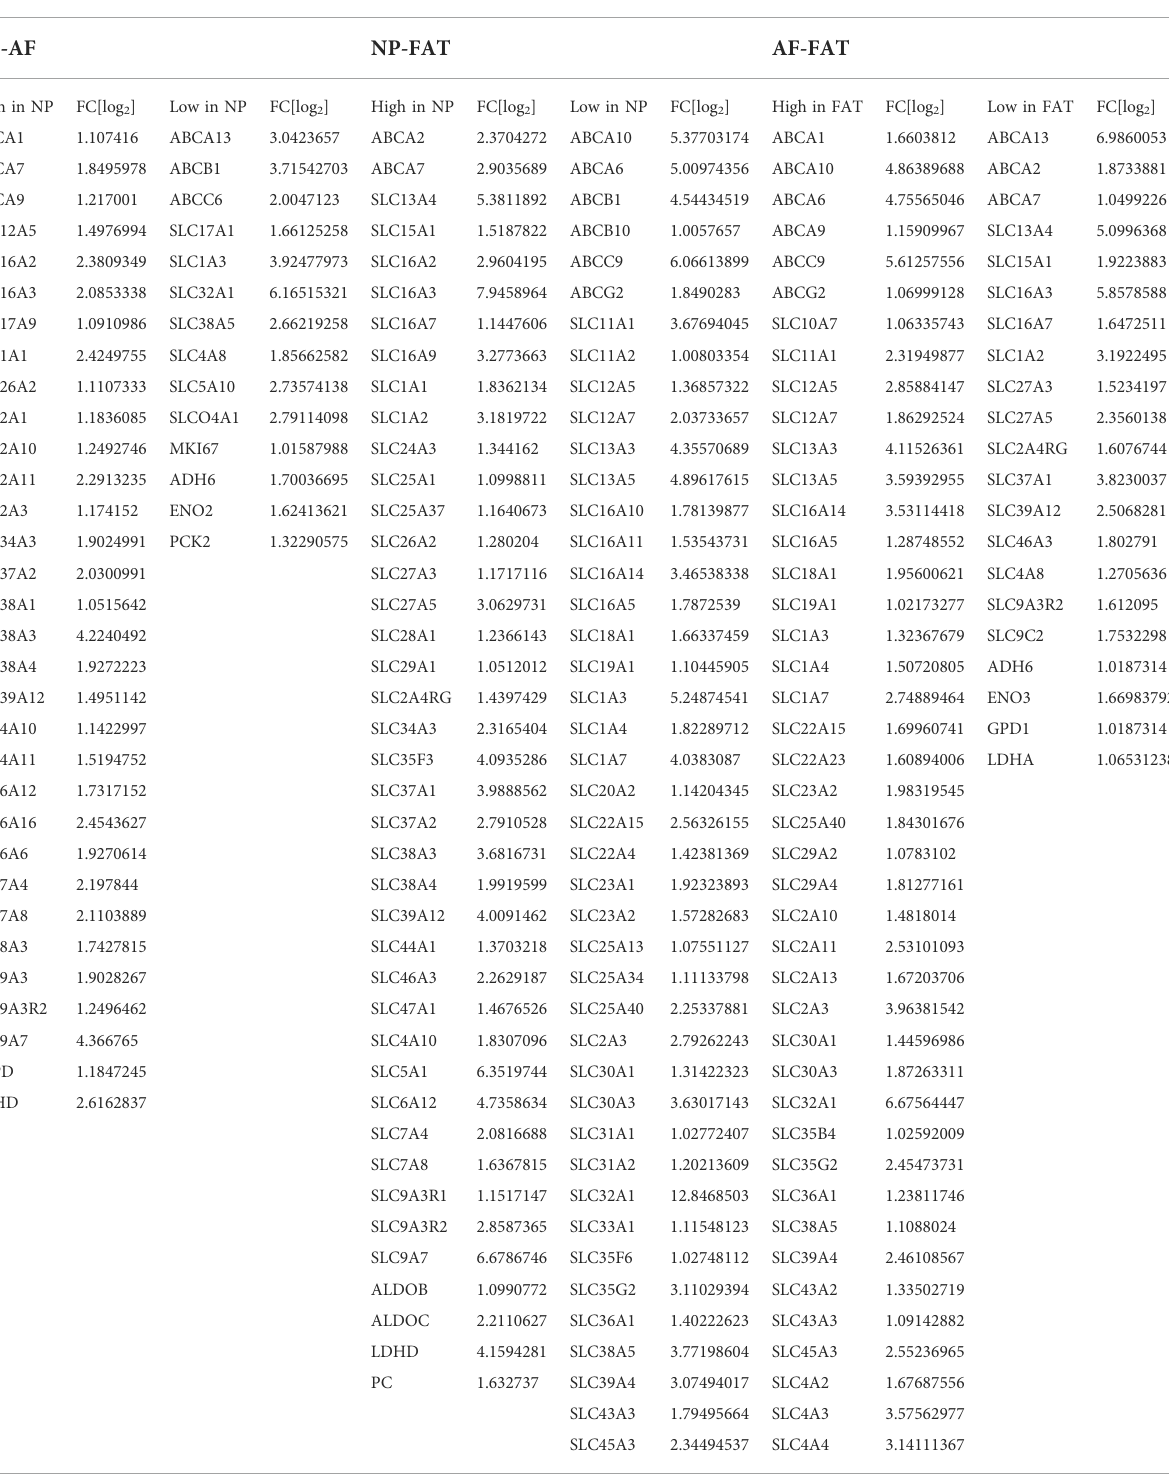
TABLE3Listofdifferentiallyexpressedgenesbetweenannulus fi brosus(AF)andnucleuspulposus(NP)cellsoftheIVDandadipose(FAT)stromalcells of the same donor associated with transporter or enzymatic function as it is related to glucose and lactate metabolism. Differences in transcript levels are displayed as log 2 fold changes (FC[log 2